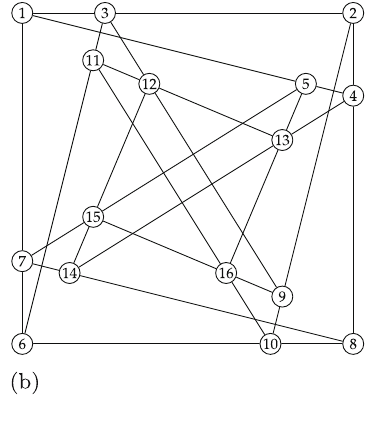
Figure 12: The two 16 332 - con fi gurations. ( a ) 16A, ( b ) 16B.